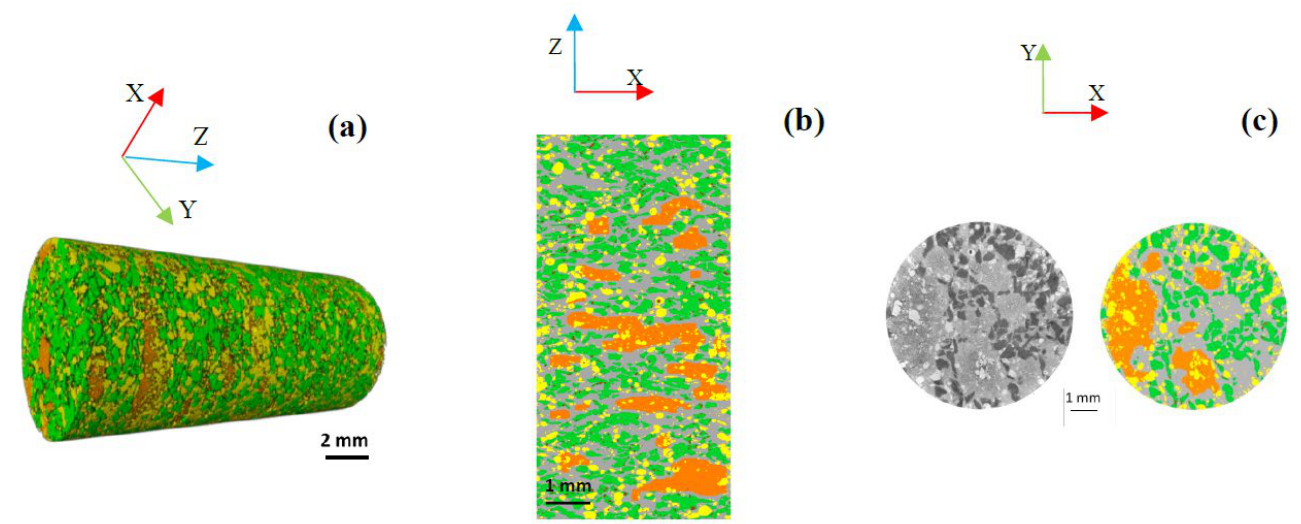
Figure 6. Spatial constituent distribution in M2; ( a ) 3D visualization, ( b ) 2D longitudinal visualization in XZ plane, ( c ) 2D orthogonal visualization in XY plane. Fiber bundles (orange), carbonaceous particles (green), matrix (gray), shots (yellow), voids (red).